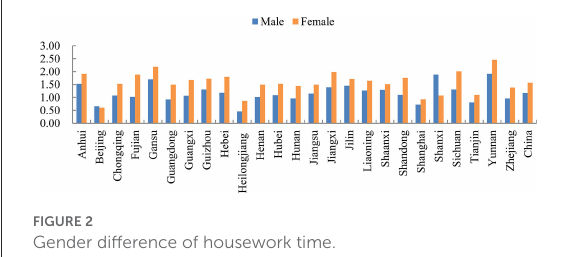
FIGURE1 Distribution of energy poverty.